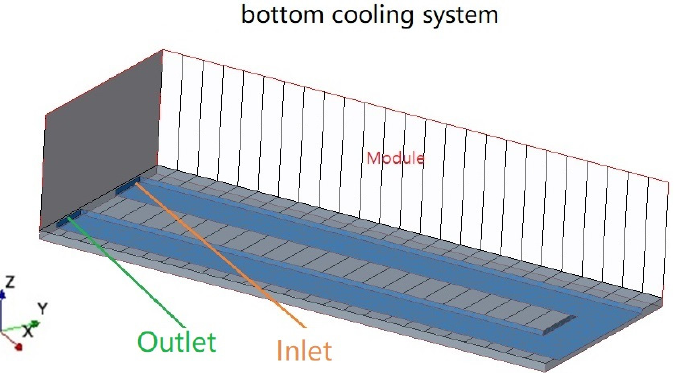
Figure 4. Perspective view of the coolant flow path created in the battery module for the bottom cooling system.